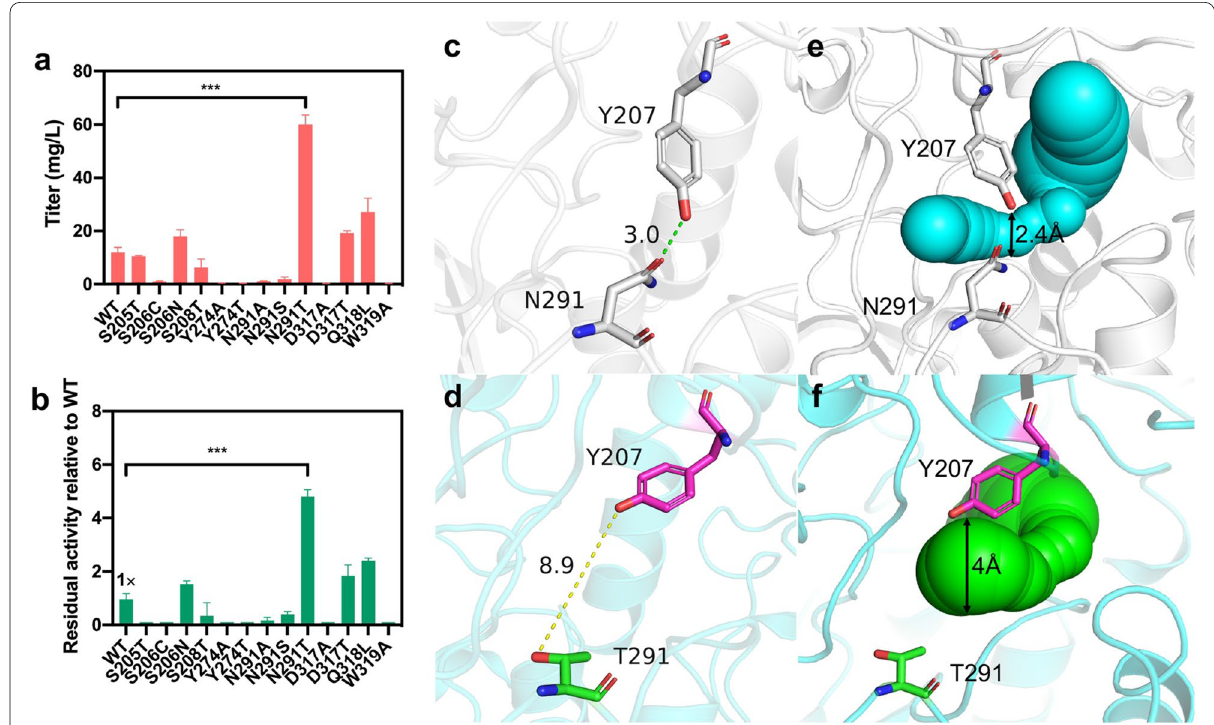
Fig. 7 a Indirubin titer of various mutants of bFMO in vivo. b Enzyme residual activities of various mutants relative to the wild‑type (1 ) toward × indole. c Hydrogen bond between Y207 and N291 is indicated by green dashed line in wild‑type bFMO. d Distance between Y207 (purple) and T291 (green) is indicated by yellow dashed lines in N291T mutant. The substrate tunnel shown in balls in wild‑type bFMO ( e ) and the N291T mutant ( f ) was identified by CAVER 3.0. Statistical analysis was performed using the Student’s t test (one‑tailed; two‑sample unequal variance; * p < 0.05, ** p < 0.01, *** p < 0.001). All data represent the mean of n 3 biologically independent samples and error bars show the standard =